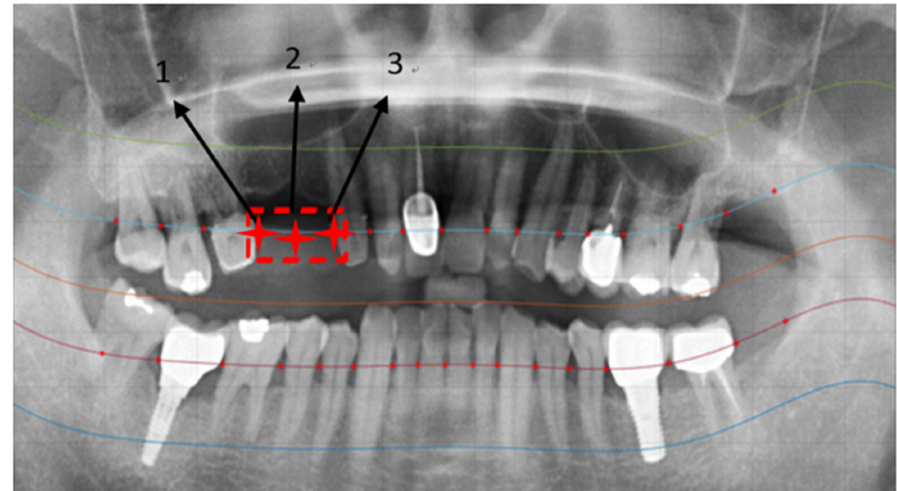
Figure 21. Missing teeth errors fixed.